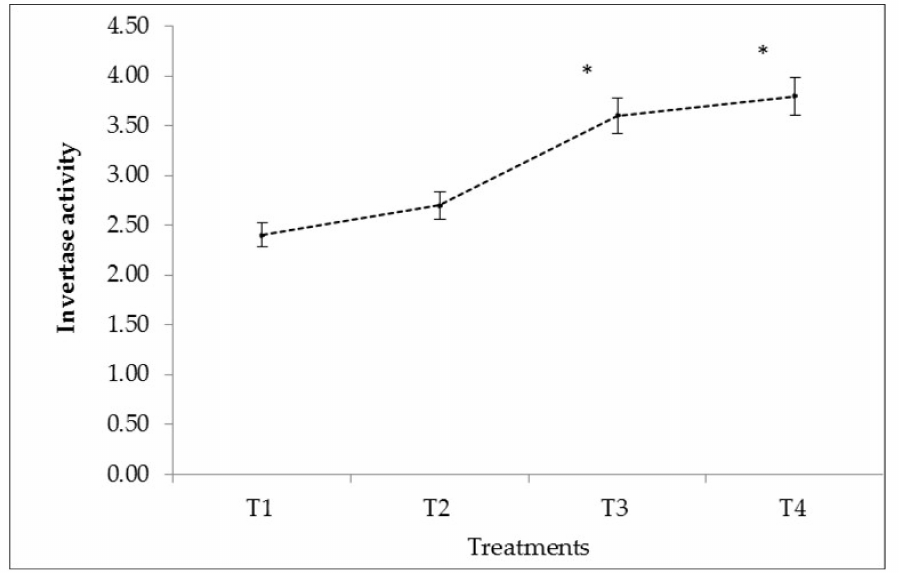
Figure 2. The effect of mineral fertilisers on invertase activity of irrigated soil in Kibray district, Tashkent Region, Uzbekistan. ( p values showing significantly different at p < 0.05 * as compared to control (T1)). Bars represens ± SD